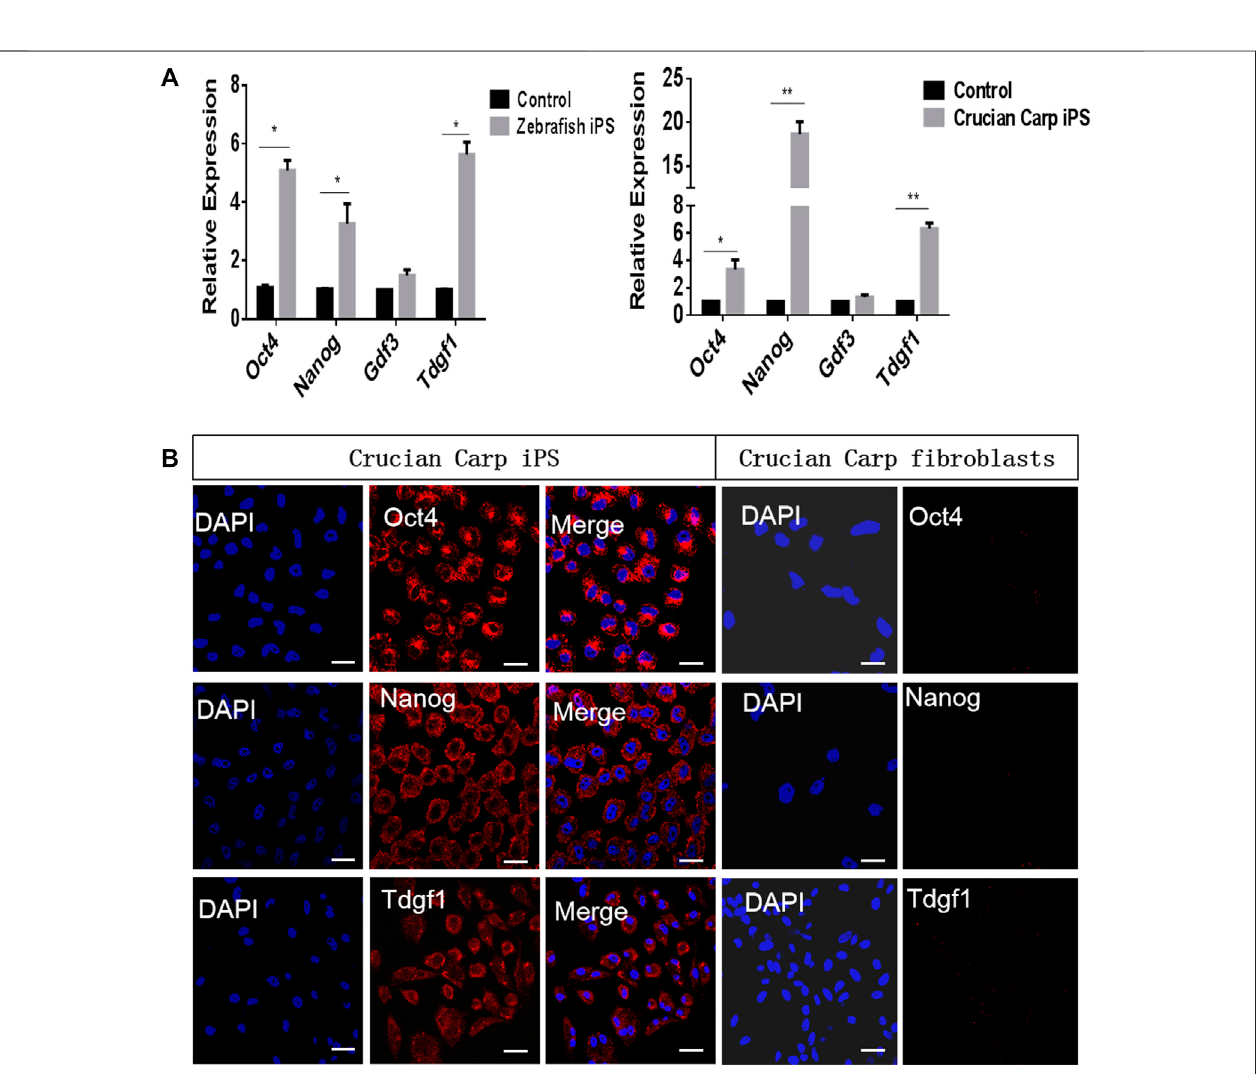
FIGURE 3 | Expression pattern of pluripotent candidate genes in iPS-like cells from zebra fi sh and crucian carp. (A) qRT-PCR analyse of pluripotent candidate genesiniPS-likecellsfromzebra fi sh(left)andcruciancarp(right).The fi broblastsfromzebra fi shandcrucianascontrol,respectively.ItwasshowedthatthemRNAlevels of Oct4,Nanog, and Tdgf1 were higher in theiPS-likecells ofzebra fi shand crucian carp, while the expression level of Gdf3 waslower. (B) Immuno fl uorescence staining of Oct4, Nanog, and Tdgf1 iPS-like cells (passage 15) from crucian carp (Scale bars represent 20 μ m). It was showed that the expression was positive in iPS-like cells, but not in fi broblasts. Data are shown as mean ± SD of values obtained from three independent experiments, and signi fi cant differences were evaluated using Student ’ s t test (* p < .005; ** p < .001). The scale bars are equal to 20 μ m.